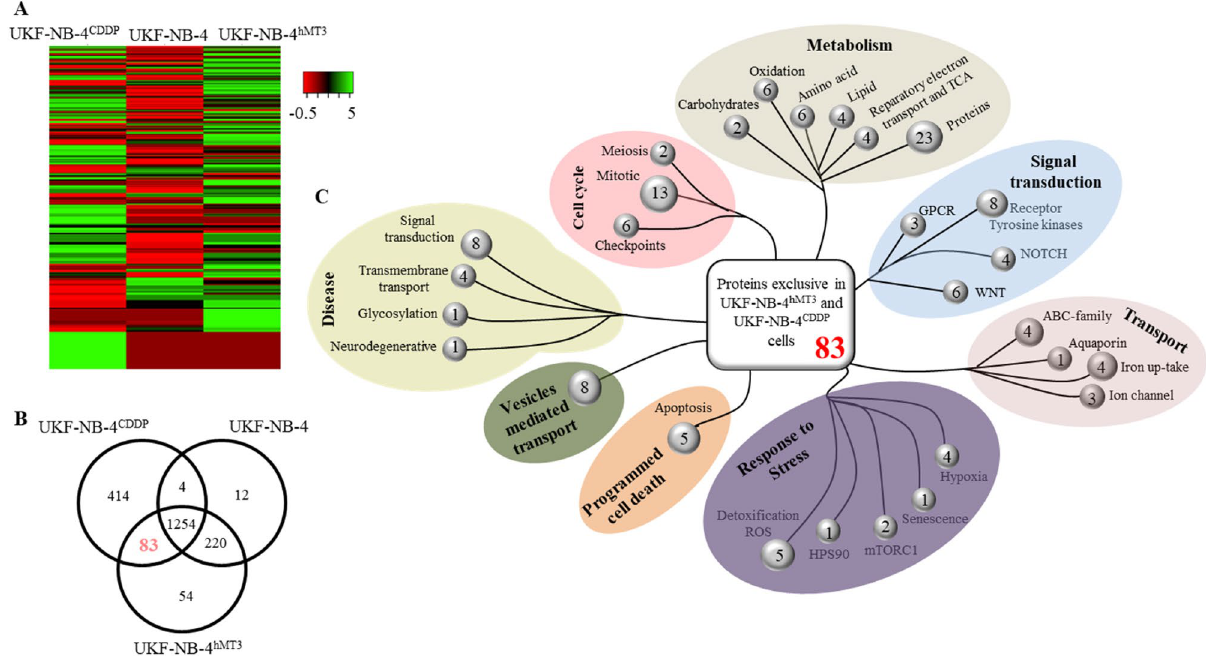
identified in proteomic signatures of parental UKF-NB-4, UKF-NB-4 hMT3 and UKF-NB-4 CDDP cells. ( C ) Classification summary of pathways of 83 commons proteins identified in UKF-NB-4 CDDP and UKF-NB-4 hMT3 cells, as predicted by DAVID and Reactome